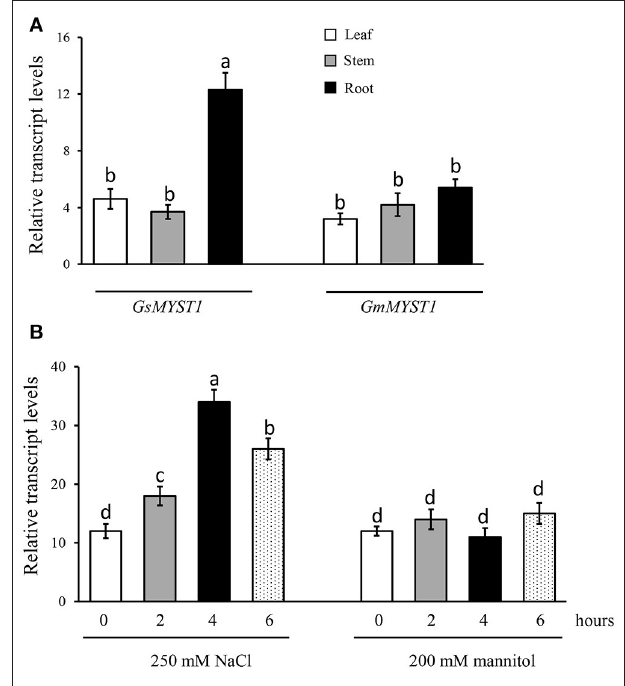
FIGURE 2 | GsMYST1 gene expression patterns in wild soybean. (A) The spatial expression patterns of GsMYST1 and GmMYST1 in different tissues of wild soybean and cultivated soybean were analyzed. Total RNA samples from the indicated tissues of 6-week-old adult plants were extracted for qRT-PCR. GAPDH was used as the internal reference. (B) Transcription levels of GsMYST1 induced by abiotic stresses. The 6-week-old young wild soybean plants were treated with salt and mannitol for the indicated time periods, and then the total RNA samples were extracted from the treated plant roots for qRT-PCR analyses. Bars indicate SE, the t-test, and the columns were shown from three biological triplicates ( t -test, p < 0.05, expressed in different small letter